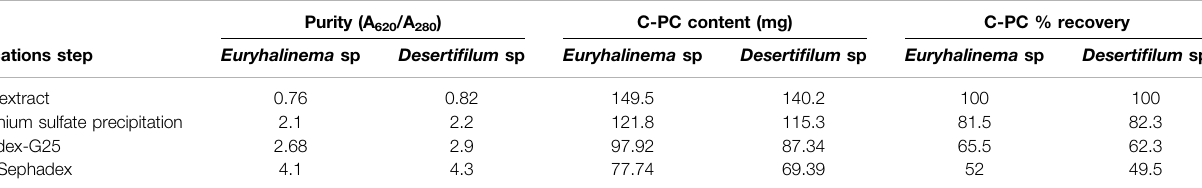
TABLE 2 | Puri fi cation pro fi le of cyanobacterial phycocyanin (C-PC) puri fi ed from the crude extract of Euryhalinema sp. and Deserti fi lum sp.